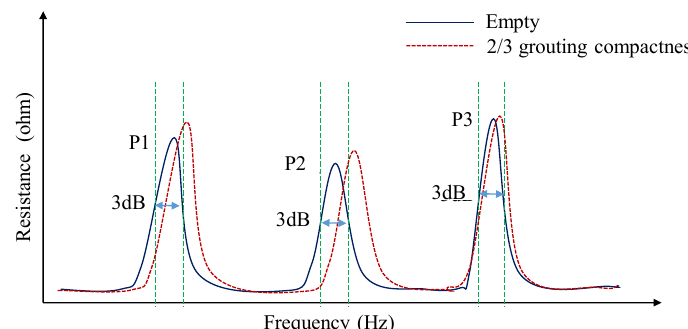
Figure 4. The impedance signatures for the PZT patches connected in series.